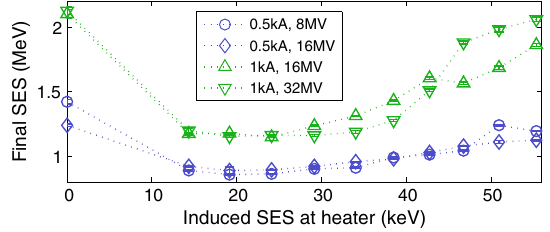
FIG. 17. SES measurements are consistent at different XTCAV voltages, confirming accuracy of the PW measurement, which is subtracted in